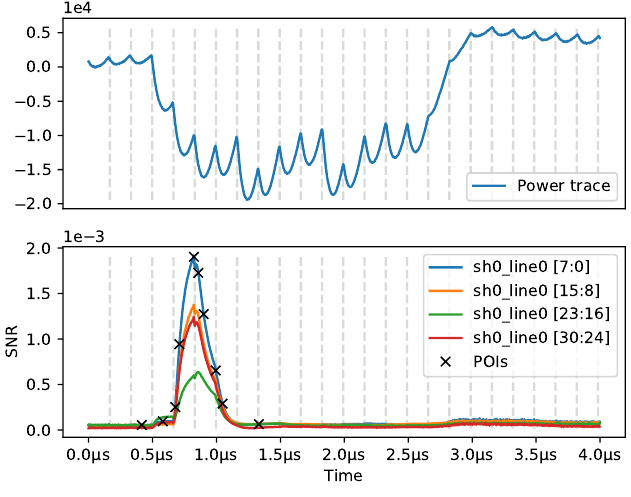
Figure 10: Top: exemplary leakage trace. Bottom: SNR for exemplary target